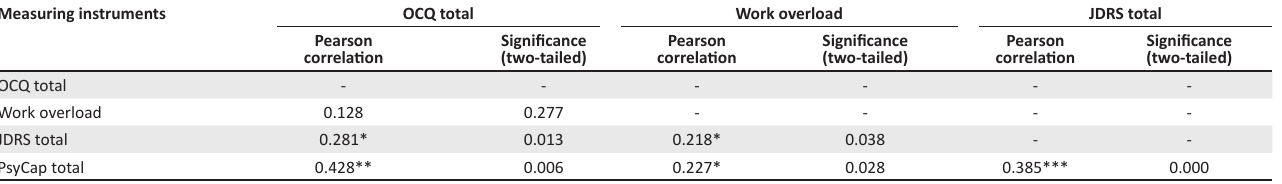
TABLE 4: Correlations between psychological capital, work overload and continuance organisational commitment. Measuring